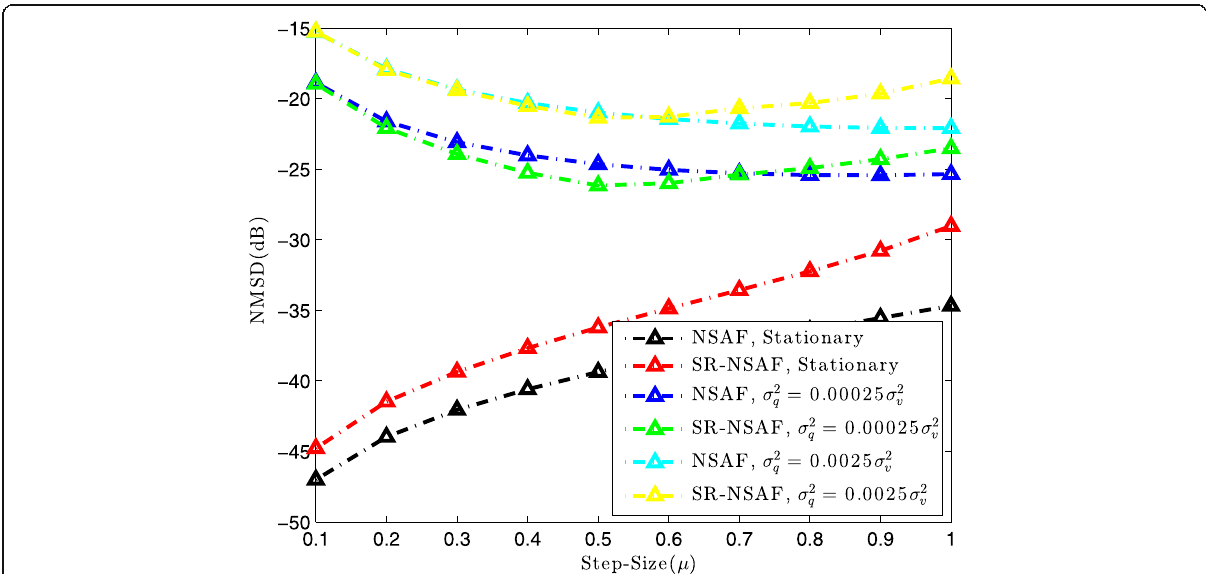
Fig. 18 Simulated steady-state NMSD of NSAF and SR-NSAF with N = 8 as a function of the step-size for different value of σ 2